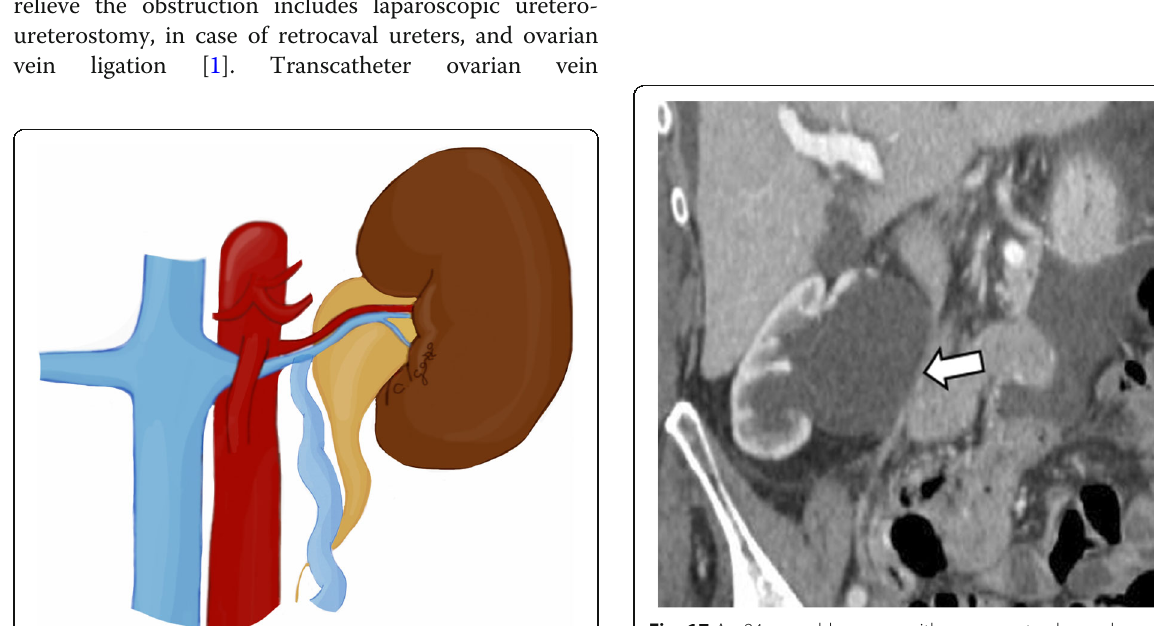
Fig. 17 An 84-year-old woman with upper ureteral vascular compression. Coronal enhanced CT image shows the proximal ureter (arrow) compressed by a dilated ovarian